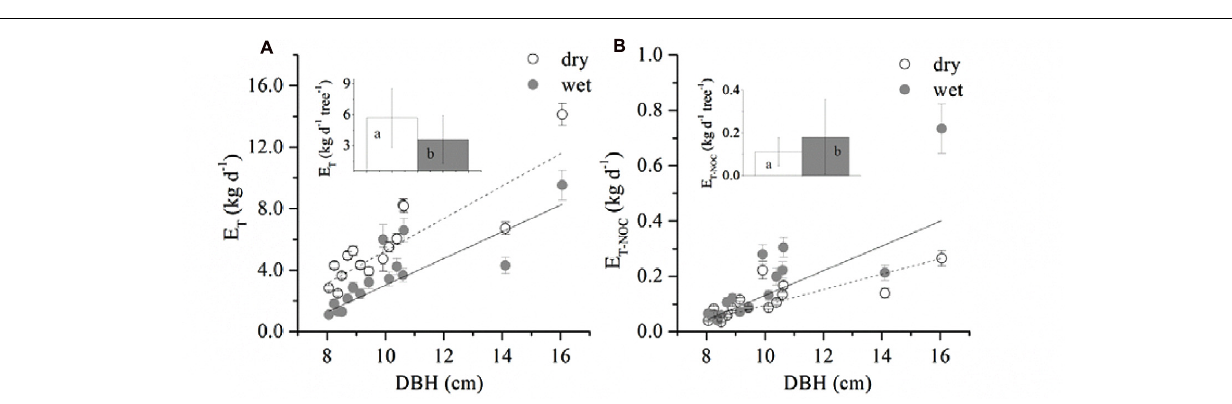
FIGURE 2 | Relationship between DBH and (A) averaged daily transpiration (E T ), (B) averaged total nocturnal sap flow (E T - NOC ). Data are mean ± SE, and all linear fittings are significant at the p < 0.05 level. The insets in the figure represent the mean E T (A) and E T - NOC (B) of all 15 trees in dry and wet seasons respectively. Different letters indicate a significant difference between dry and wet